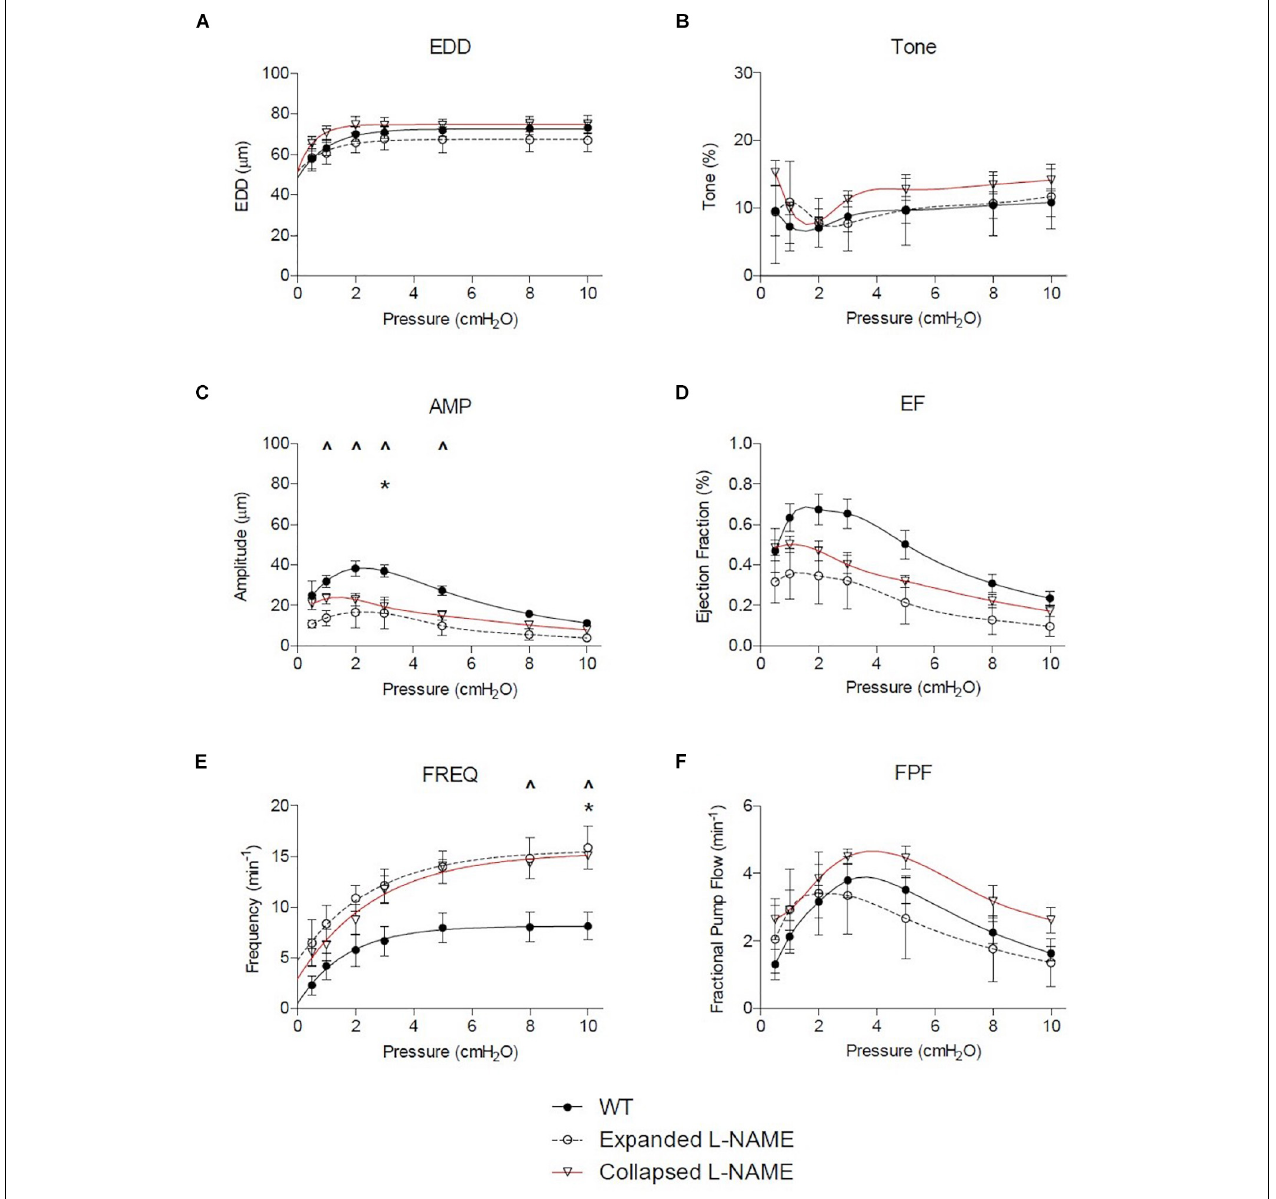
FIGURE 4 | Nitric oxide synthase inhibition corrects TNF-Tg lymphatic vessel defects in contractile function. The lymphatic vessels described in Figure 1 were treated with L-NAME (10 − 4 M) and assessed for EDD, % tone, AMP, EF, FREQ, and FPF at the indicated pressures. All data are means ( ± SEM). When error bars appear missing, they are contained within the data points (* P < 0.05 Expanded + L-NAME vs. WT; ∧ P < 0.05 Collapsed + L-NAME vs.